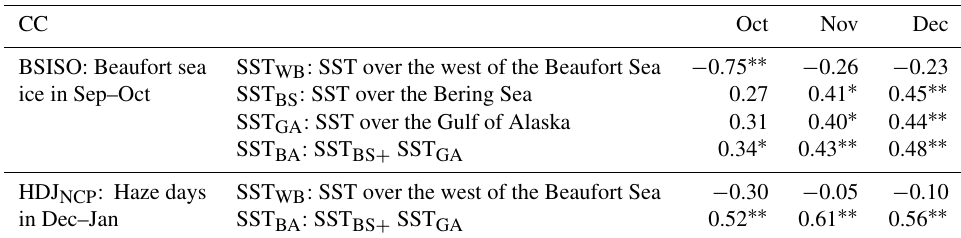
Table 1. The correlation coefficient (CC) between the BSISO (HDJ NCP ) and SST indices in October, November and December. The linear trend was removed. The “*” indicates that the CCs exceed the 95% confidence level, and “**” indicates that the CCs exceed the 99% confidence level. The meanings of the abbreviations were also